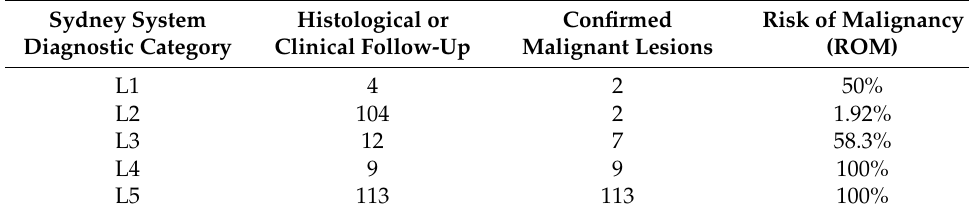
Table 5. Stratification of ROM in the Sydney system diagnostic categories. Sydney